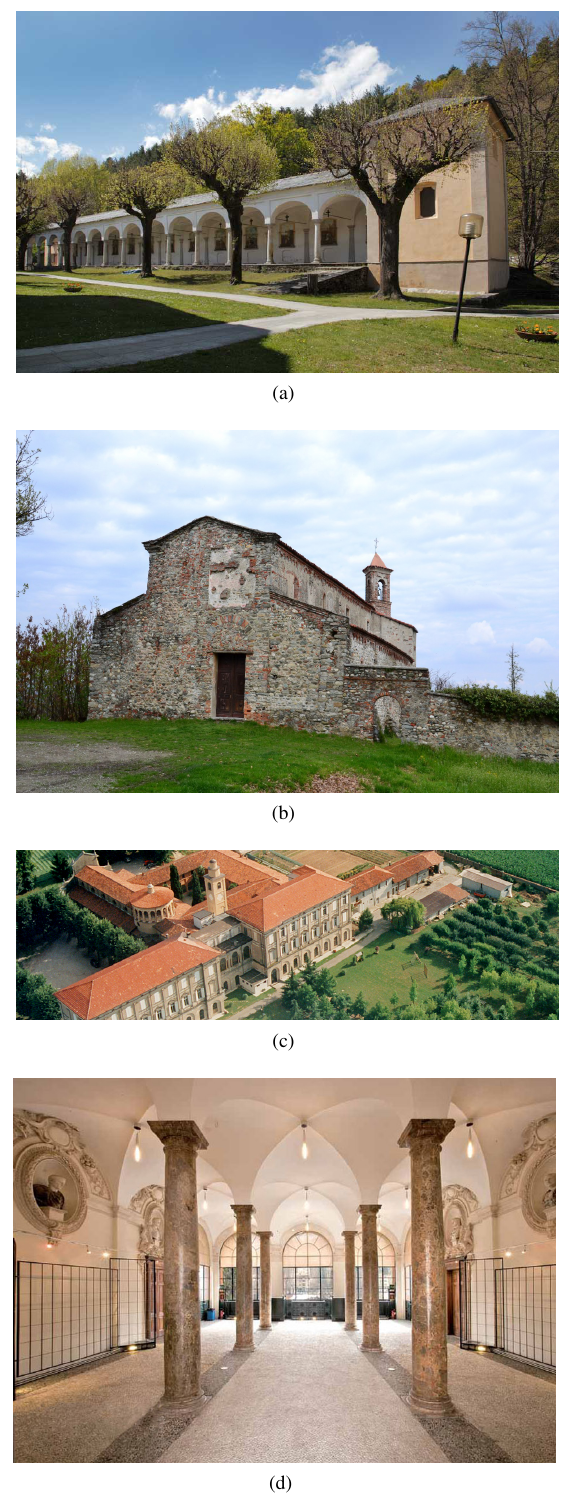
Figure 2. The four case studies used for the dataset creation and